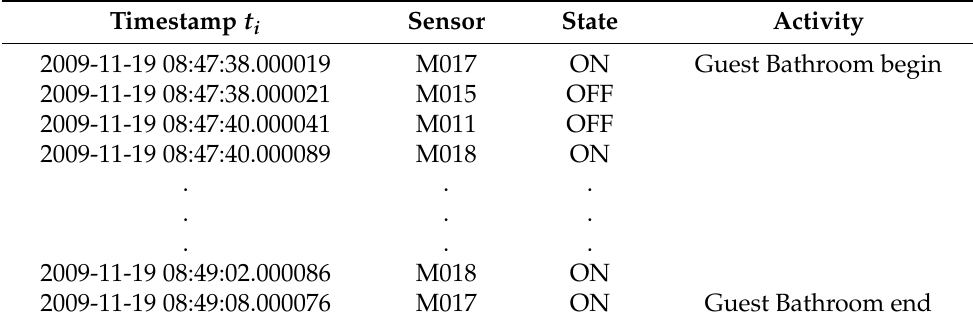
Table 2. Milan dataset